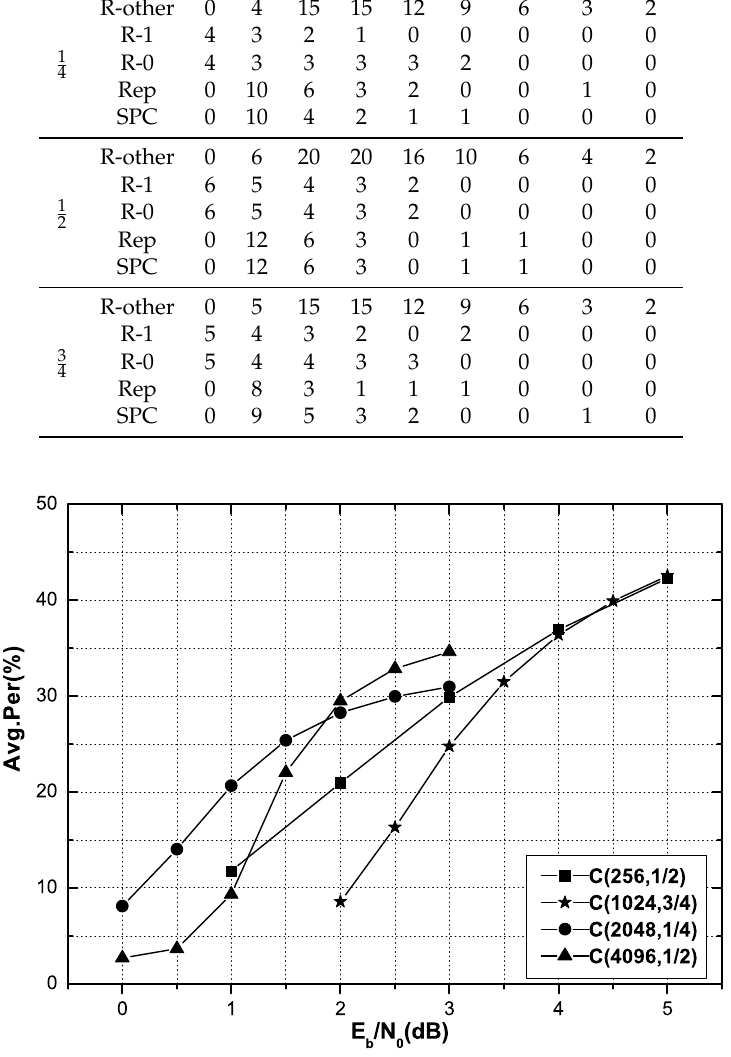
Figure 4. Average percentages of R-other nodes under Fast-ISSC satisfying